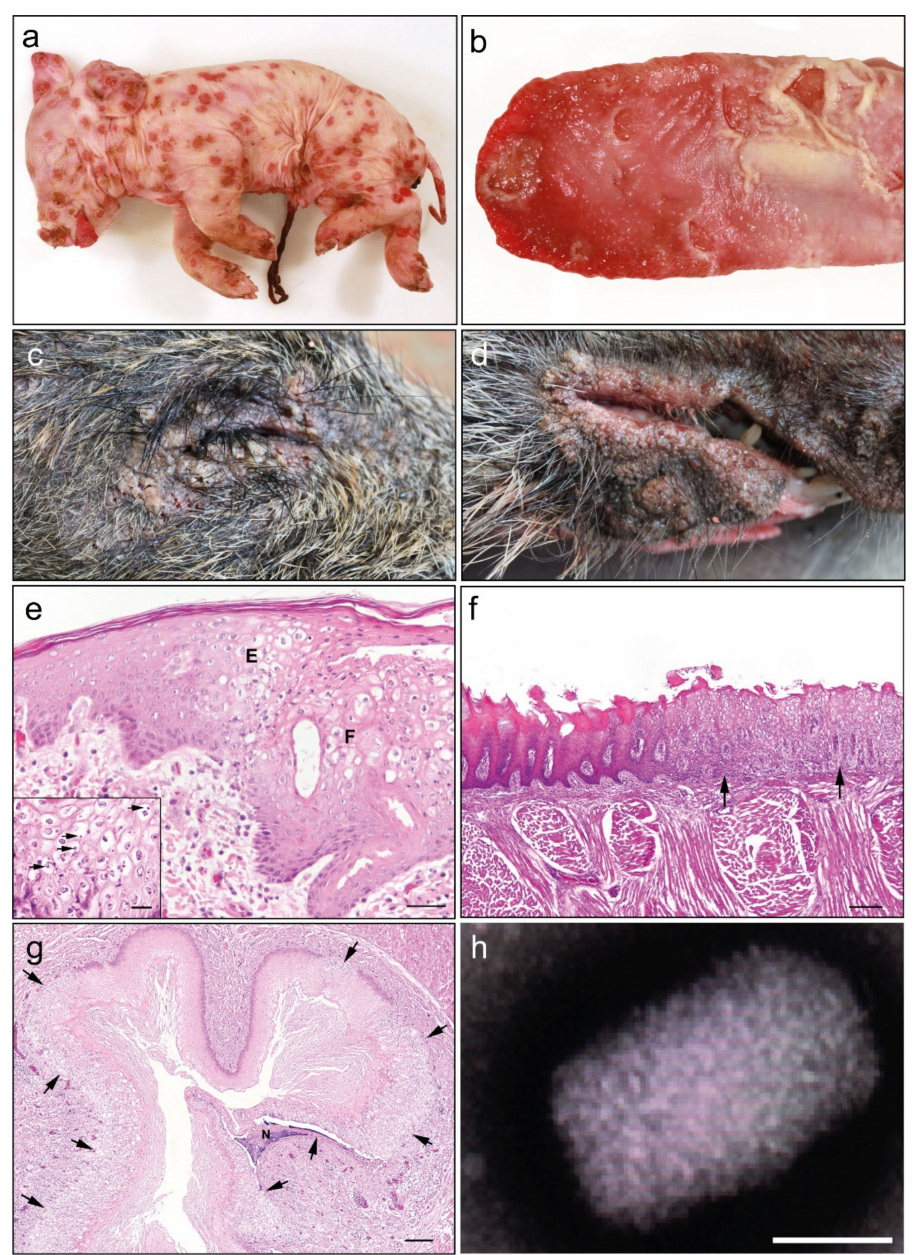
Figure 1. Pathological and ultrastructural investigation of tissues from animals diagnosed with SWPV infection. ( a ) Macroscopic skin lesions visible as multifocal severe, erythematous maculae on a SWPV-infected piglet. ( b ) Tongue of a one-day-old SWPV-infected piglet with multifocal coalescing vesicular to bullous lesions and consecutive erosions. ( c , d ) Macroscopic skin lesions consisting of multiple crusted pustules surrounding the eye ( c ) and lip ( d ) of a juvenile wild boar. ( e ) Skin of a one-day-old piglet infected with SWPV characterized by ballooning degeneration of the epidermal (E) and follicular (F) epithelial cells; HE, bar = 100 µ m; inset: higher magnification reveals cytoplasmic eosinophilic inclusion bodies in degenerated epidermal cells (arrows); HE, bar = 20 µ m. ( f ) Tongue of a one-day-old piglet infected with SWPV characterized by focal severe ballooning degeneration of the epithelial cells (arrows); adjacent regular epithelial lining; HE, bar = 200 µ m. ( g ) Esophagus of a one-day-old piglet infected with SWPV characterized by multifocal severe ballooning degeneration of the epithelial cells (arrows); focal intraepithelial necrosis (N); HE, bar = 200 µ m. ( h ) Ultrastructure of a characteristic orthopoxvirus particle in the skin of a piglet demonstrated by negative staining, bar = 100